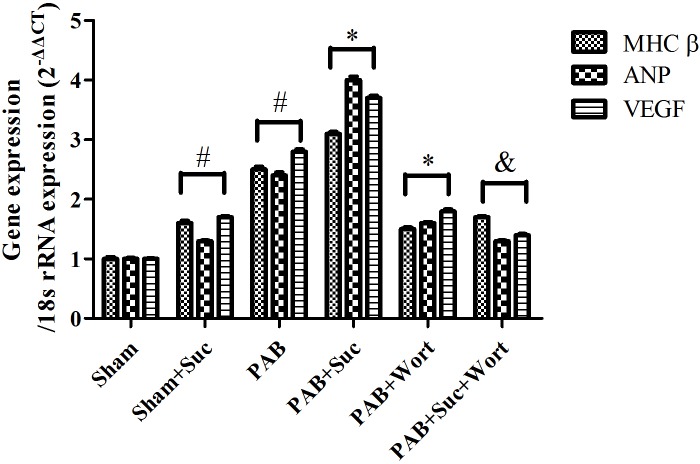
The expression levels of the RVH-associated genes myosin heavy chain-β (MHC-β), atrial natriuretic peptide (ANP) and vascular endothelial growth factor (VEGF) in each group (n = 8); #P<0.05 compared to the sham group; *P<0.05 compared to the PAB group.